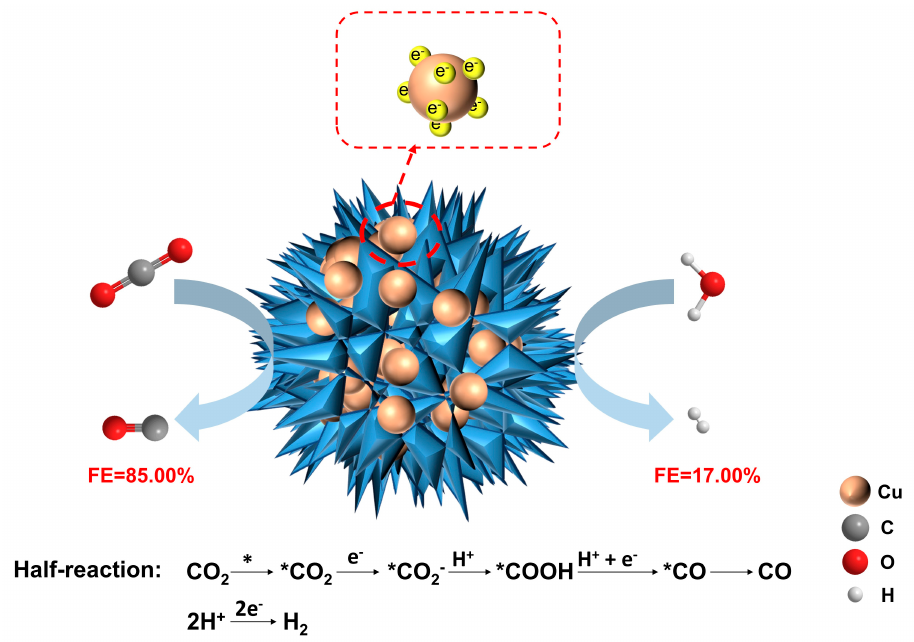
Figure 5. The mechanism of converting CO 2 to CO on PdCu − 2. (Here, the * is used as an indicator of activated substrates or surfaced attached species in the work).